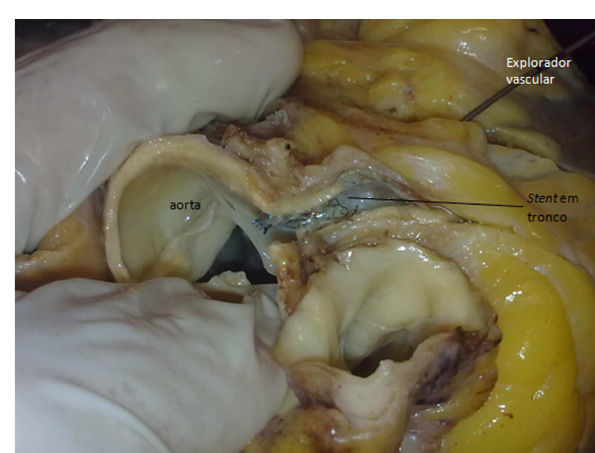
Fig. 2 - Extrusão parcial do stent implantado em tronco de coronária esquerda para dentro da luz da aorta, evidenciado durante o exame anátomo-patológico